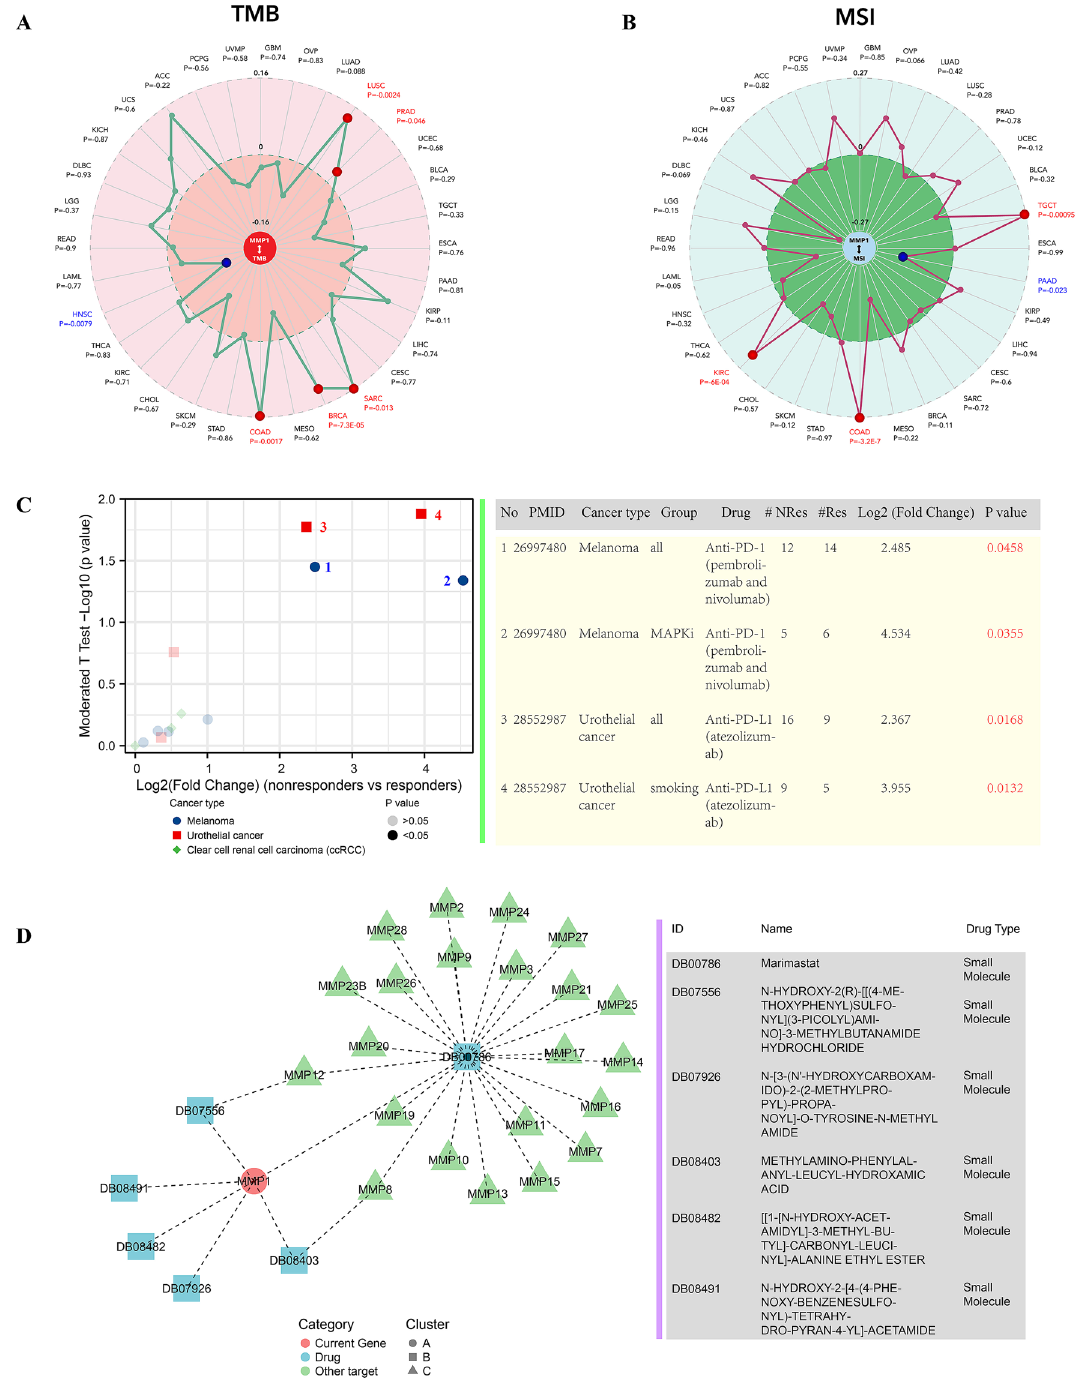
Figure 11. MMP1 immunotherapies and relevant drugs. ( A ) Correlation between MMP1 expression and tumor mutational burden (TMB); ( B ) Correlation between MMP1 expression and microsatellite instability (MSI); ( C ) Evaluation of immunotherapies associated with MMP1; ( D ) prediction of MMP1-related drugs. * P < 0.05, ** P < 0.01, *** P <